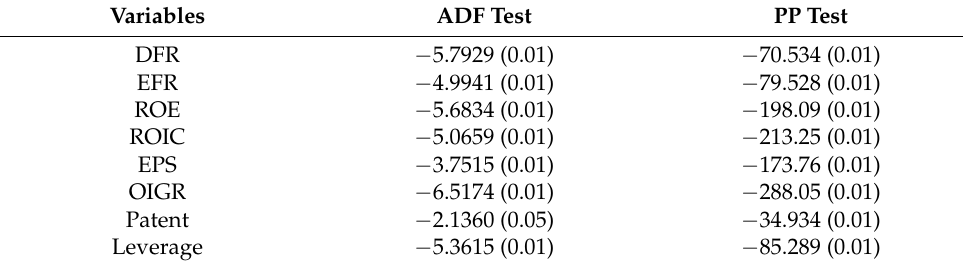
Table 2. The results of unit root